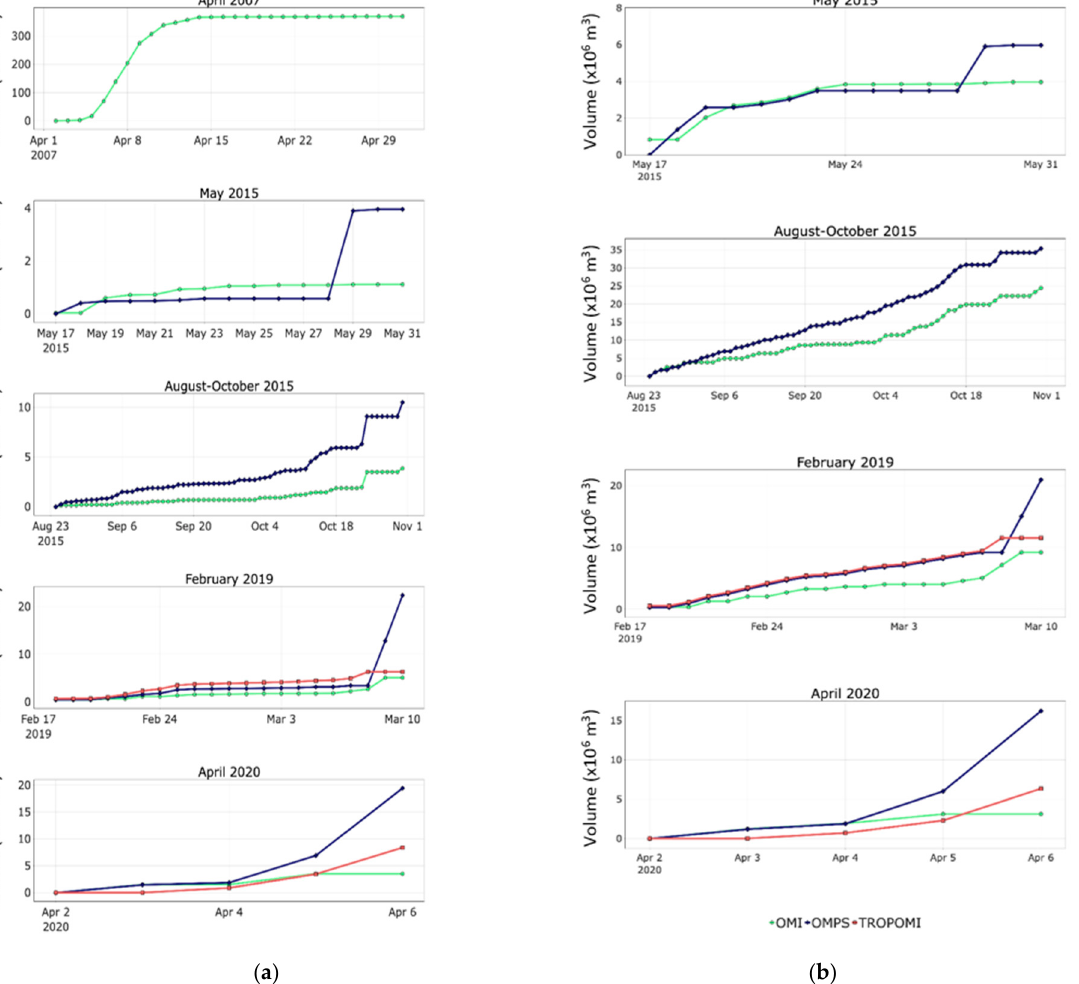
Figure 10. ( a ) DRE cumulative lava volume estimated by fixing the sulfur content within melt inclusions at 1050 ppm (35% uncertainty); ( b ) DRE cumulative lava volume estimated using sulfur contents calculated from the MIROVA lava volume (45% uncertainty). Hence, note the relationship between them. Anomalous sulfur contents (greater than 2000 ppm) were replaced with 1250 or 1600 ppm. As no estimated sulfur content within the melt inclusion was realistic for the April 2007 eruption by using the MIROVA lava volume, the second approach was not applied.